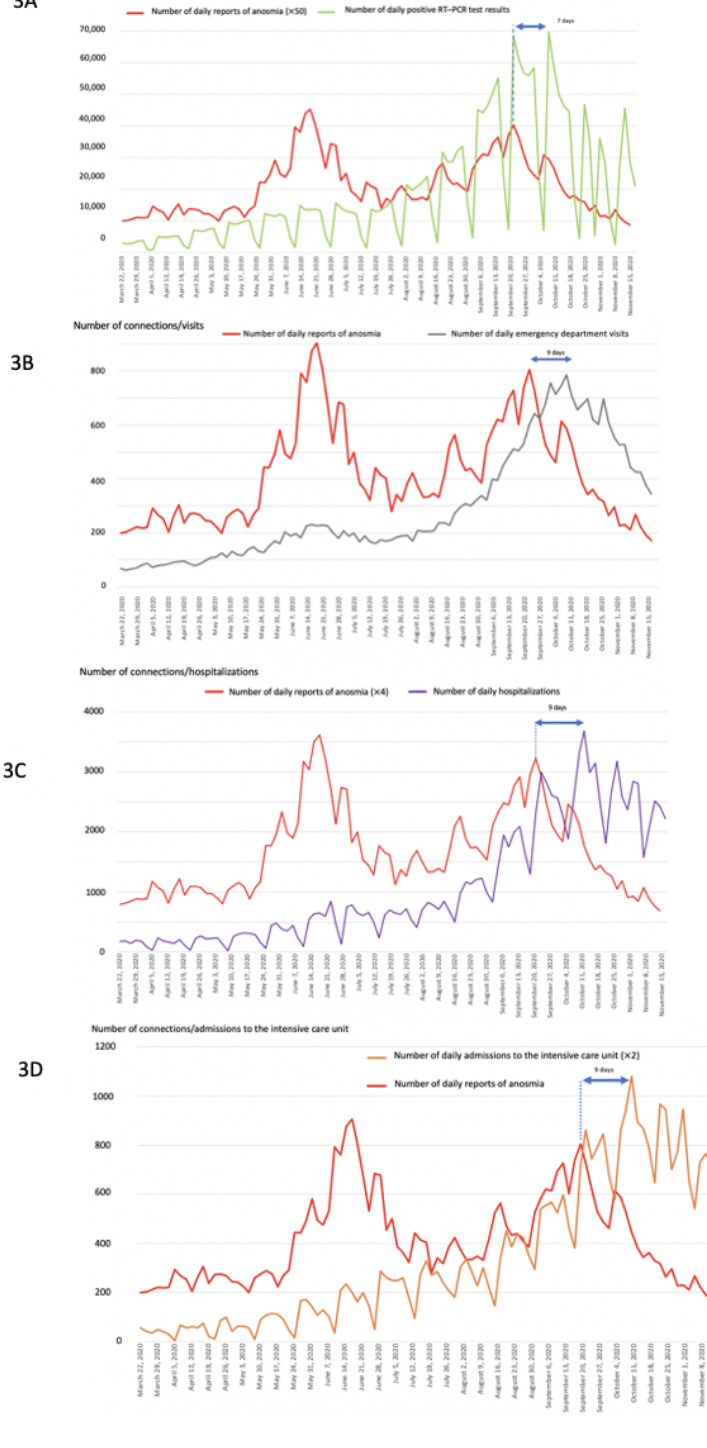
Figure 3. Trends of the COVID-19 pandemic during the second wave of infections in France from August 10 to November 18, 2020: (3A) comparison between the number of daily reports of anosmia and positive outcomes on daily RT–PCR tests; (3B) comparison between the number of daily reports of anosmia and the number of emergency department visits; (3C) comparison between the number of daily reports of anosmia and the number of daily hospitalizations; and (3D) comparison between the number of daily reports of anosmia and the number of daily admissions to the intensive care